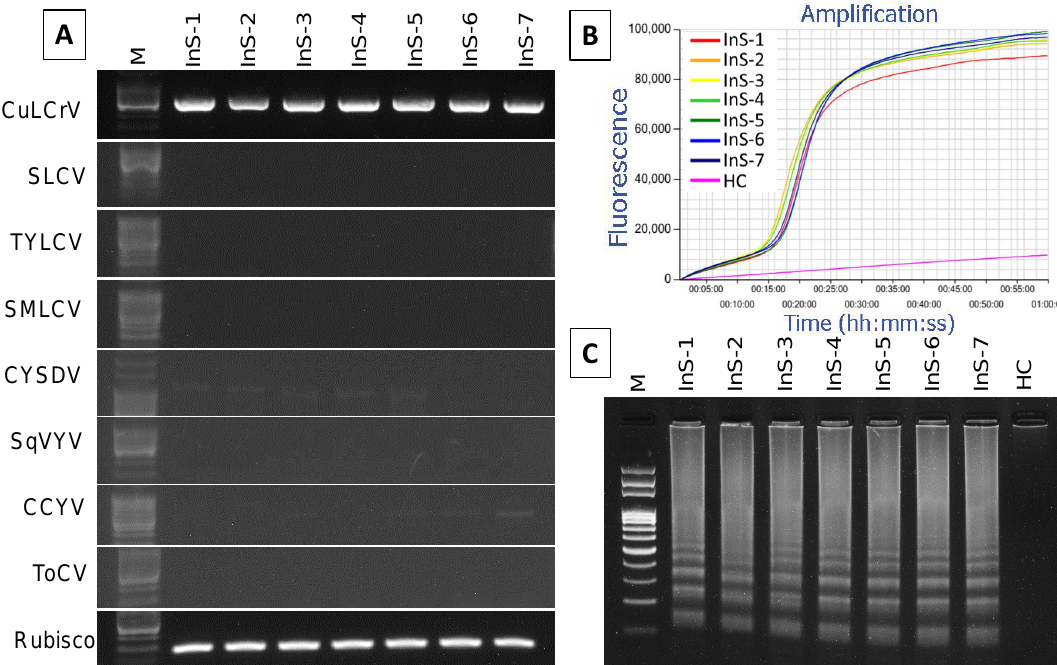
Figure 7. LAMP amplification of CuLCrV in mix infected winter squash field samples. Virus-specific primers by PCR (CuLCrV, SLCV, TYLCV and SMLCV) and RT-PCR (CYSDV- Cucurbit yellow stunting disorder virus , SqVYV- Squash vein yellowing virus , CCYV- Cucurbit chlorotic yellows virus and ToCV- Tomato chlorosis virus ) detected infections of several viruses from infected winter squash collected from Lowndes county ( A ). Rubisco was amplified as an internal control gene ( A ). LAMP amplified products were analyzed by agarose gel electrophoresis ( C ), and real-time amplification by Genie ® III ( B ). Here, InS-1 to 7: infected samples 1 to 7 collected from field, HC: healthy squash leaf as healthy control, and M: 100 bp DNA ladder ( A , C ). Successful LAMP amplification is demonstrated by the curve amplified by Genie ® III ( C